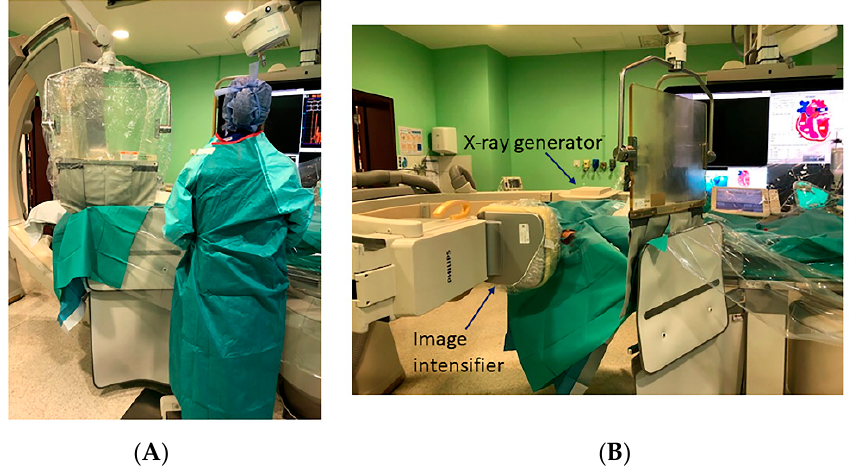
Figure 33. ( A ) Ceiling and table protective shields. ( B ) Reverse lateral projection.